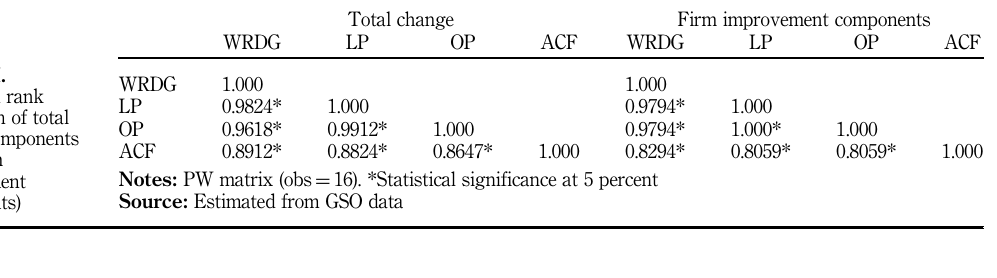
Table VII. Spearman rank correlation of reallocation components (or of entry